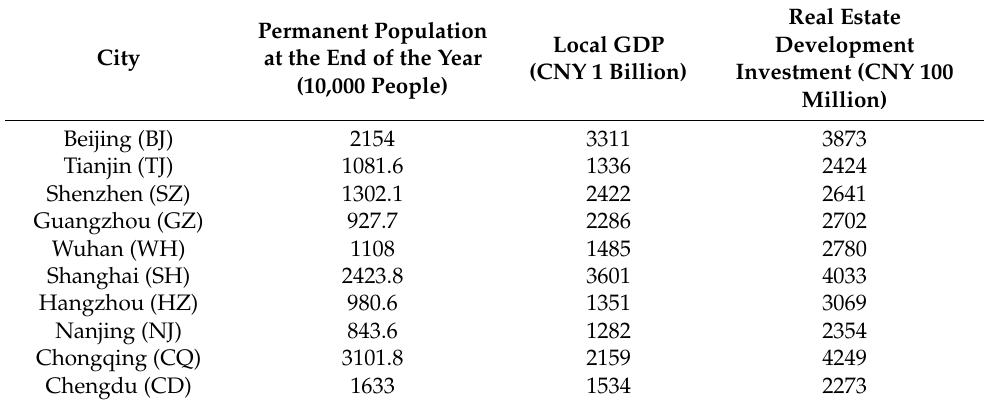
Table 1. Basic characteristics of 10 major cities.